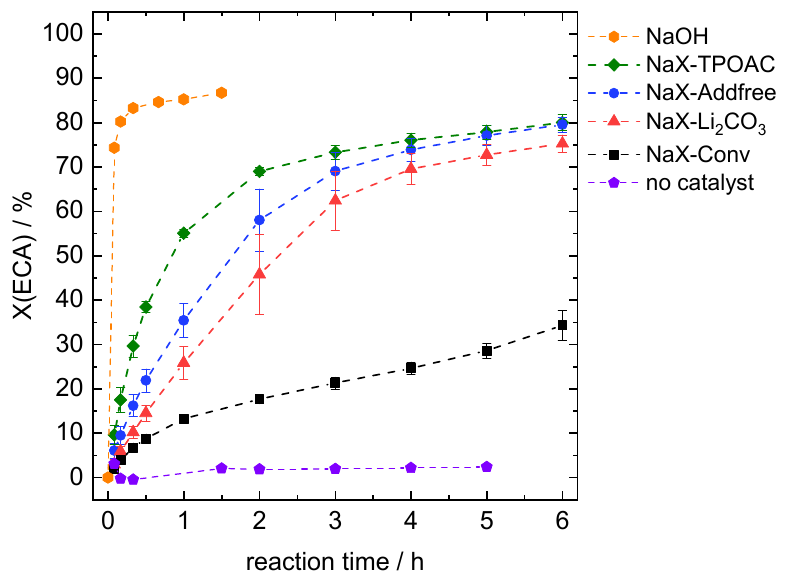
Figure 6. Conversion of ethyl cyanoacetate (ECA) in the Knoevenagel condensation with benzaldehyde for all four zeolite X samples and, for comparison, the conversion in presence of NaOH solution as well as without catalyst at 100 °C reaction temperature.